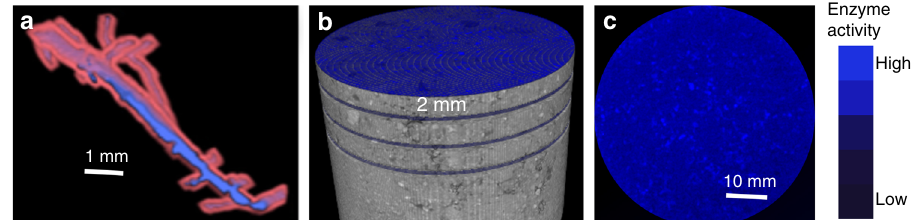
Fig. 2 Illustration of the steps involved in pore characterization and in combining 2D zymography and 3D X-ray µ CT scanning. a The volume of the soil matrix (pink) within 180 µ m distance from ≥ 30 µ m pores (blue) was used as an approximate indicator of the size of the soil matrix that can be potentially affected by C processing taking place within pores. b After µ CT scanning (at 30 µ m resolution) each soil core was cut into slices, with 2 mm distance between the slices. Each core contained 8 – 16 slices, and, in most of the cores, zymograms of each enzyme were obtained on two slices per core. c A membrane saturated with an enzyme-speci fi c substrate was placed on the surface of each slice and a zymogram was